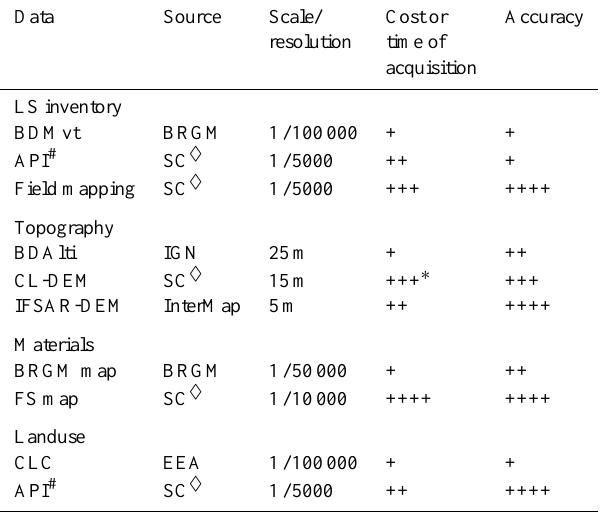
Table 1. Presentation of the source, resolution or scale and esti- mated cost and accuracy of the available data sets. + Very low, ++ low, +++ high, ++++ very high, ∗ low cost of acquisition, but time- consuming procedure, # air-photo interpretation, ated for the study.